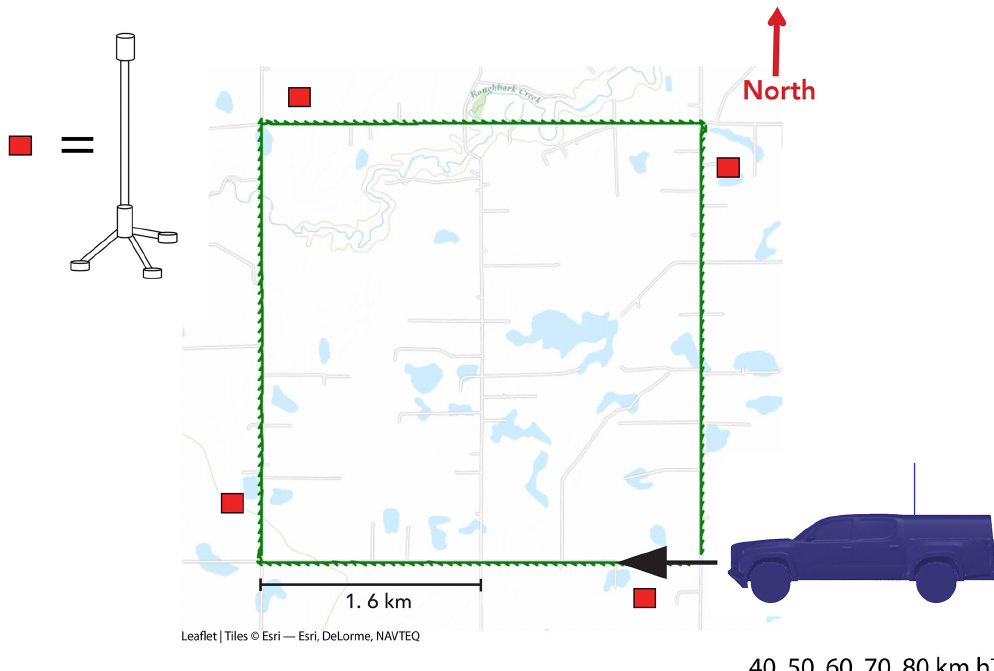
Figure 2. Field schematic displaying the location of stationary anemometers, the site and the vehicle path. The vehicle path was driven clockwise and repeated at speeds of 40, 50, 60, 70, and 80kmh − 1 . Map data: ©Esri – Esri, DeLorme,